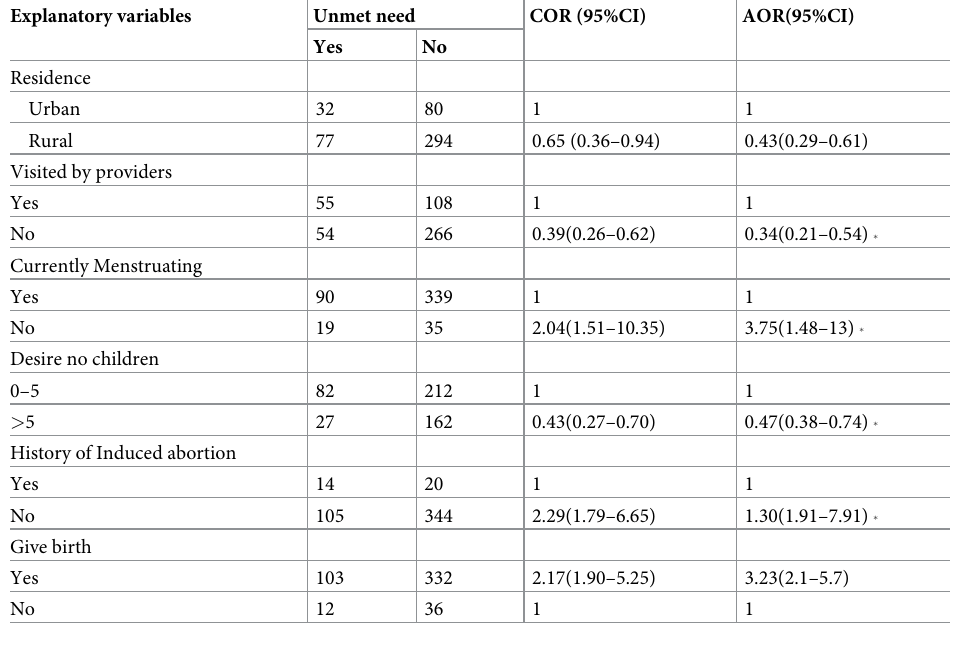
Table 7. Factors associated with the unmet need of modern family planning among reproductive-aged women in South Gondar, Ethiopia, 2017 (n = 483). Explanatory